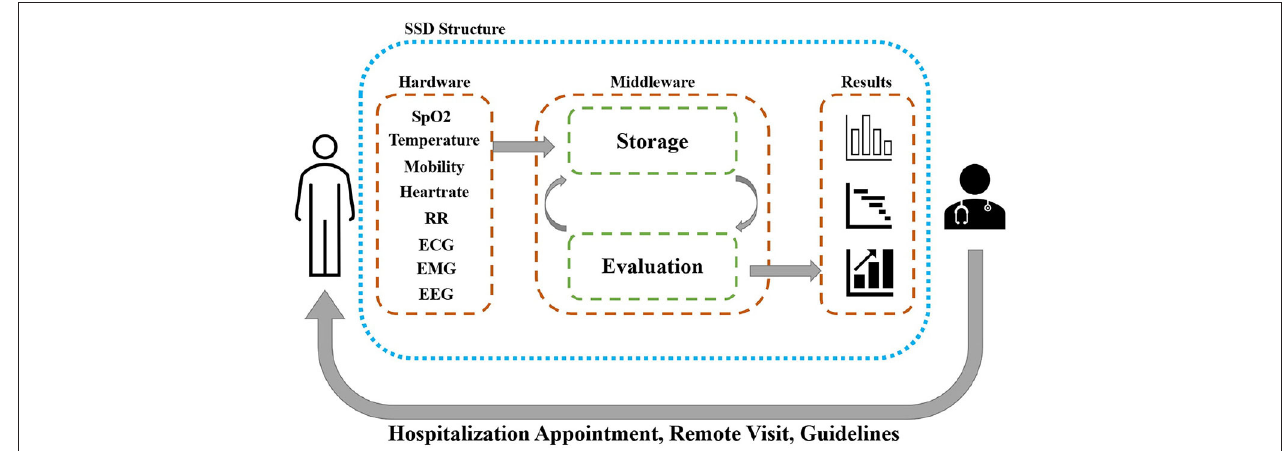
FIGURE 1 | Functionality of